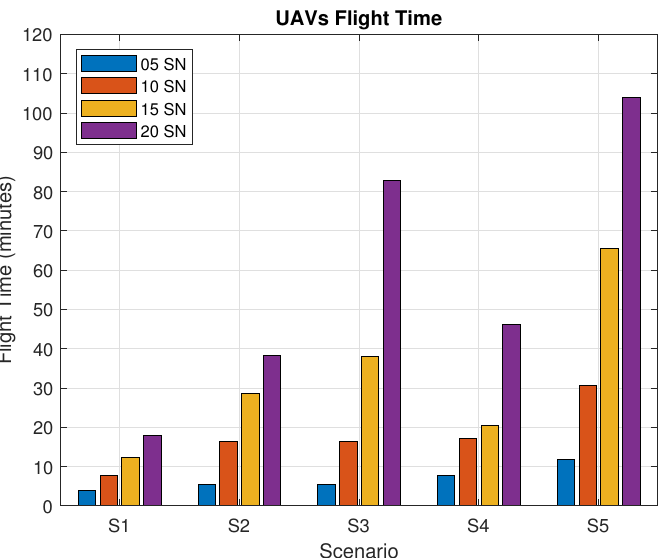
Figure 16. Flight time for each